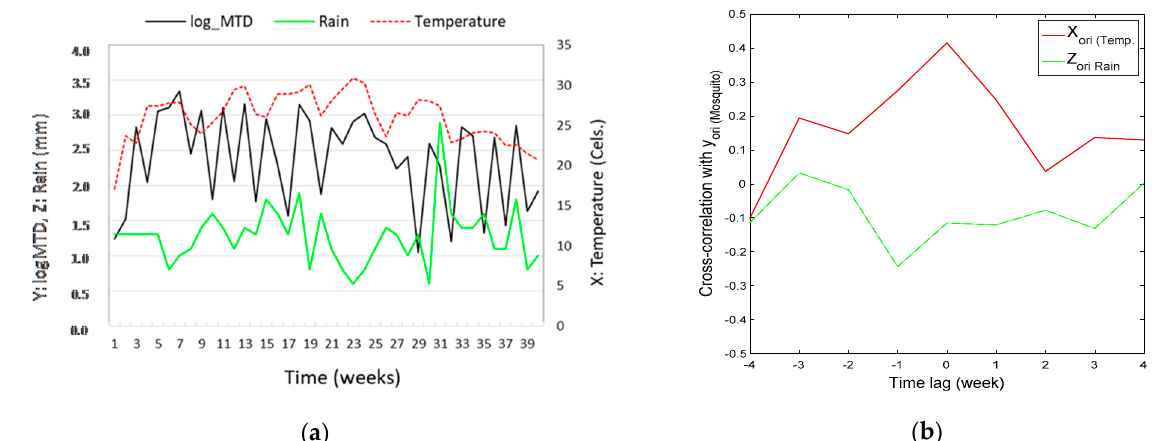
Figure 1. ( a ) Observed time series of mosquito abundance-natural logarithm (Y: log MTD), rain levels (Z: Rain) and mean temperature (X: Temperature (°C)). The data correspond to two consecutive periods of mosquito activity (combined periods of 2011 and 2012). If there are multiple panels, they should be listed as: ( b ) cross-correlation between mosquito abundance and temperature (red line) and between mosquito abundance and rain (green line) as function of time lag (weeks). Note that there is a positive correlation for temperature and that the cross-correlation at time lag zero is highest for temperature. Hence, it is best to condition the temperature at the moment itself and not a week earlier or a week later.